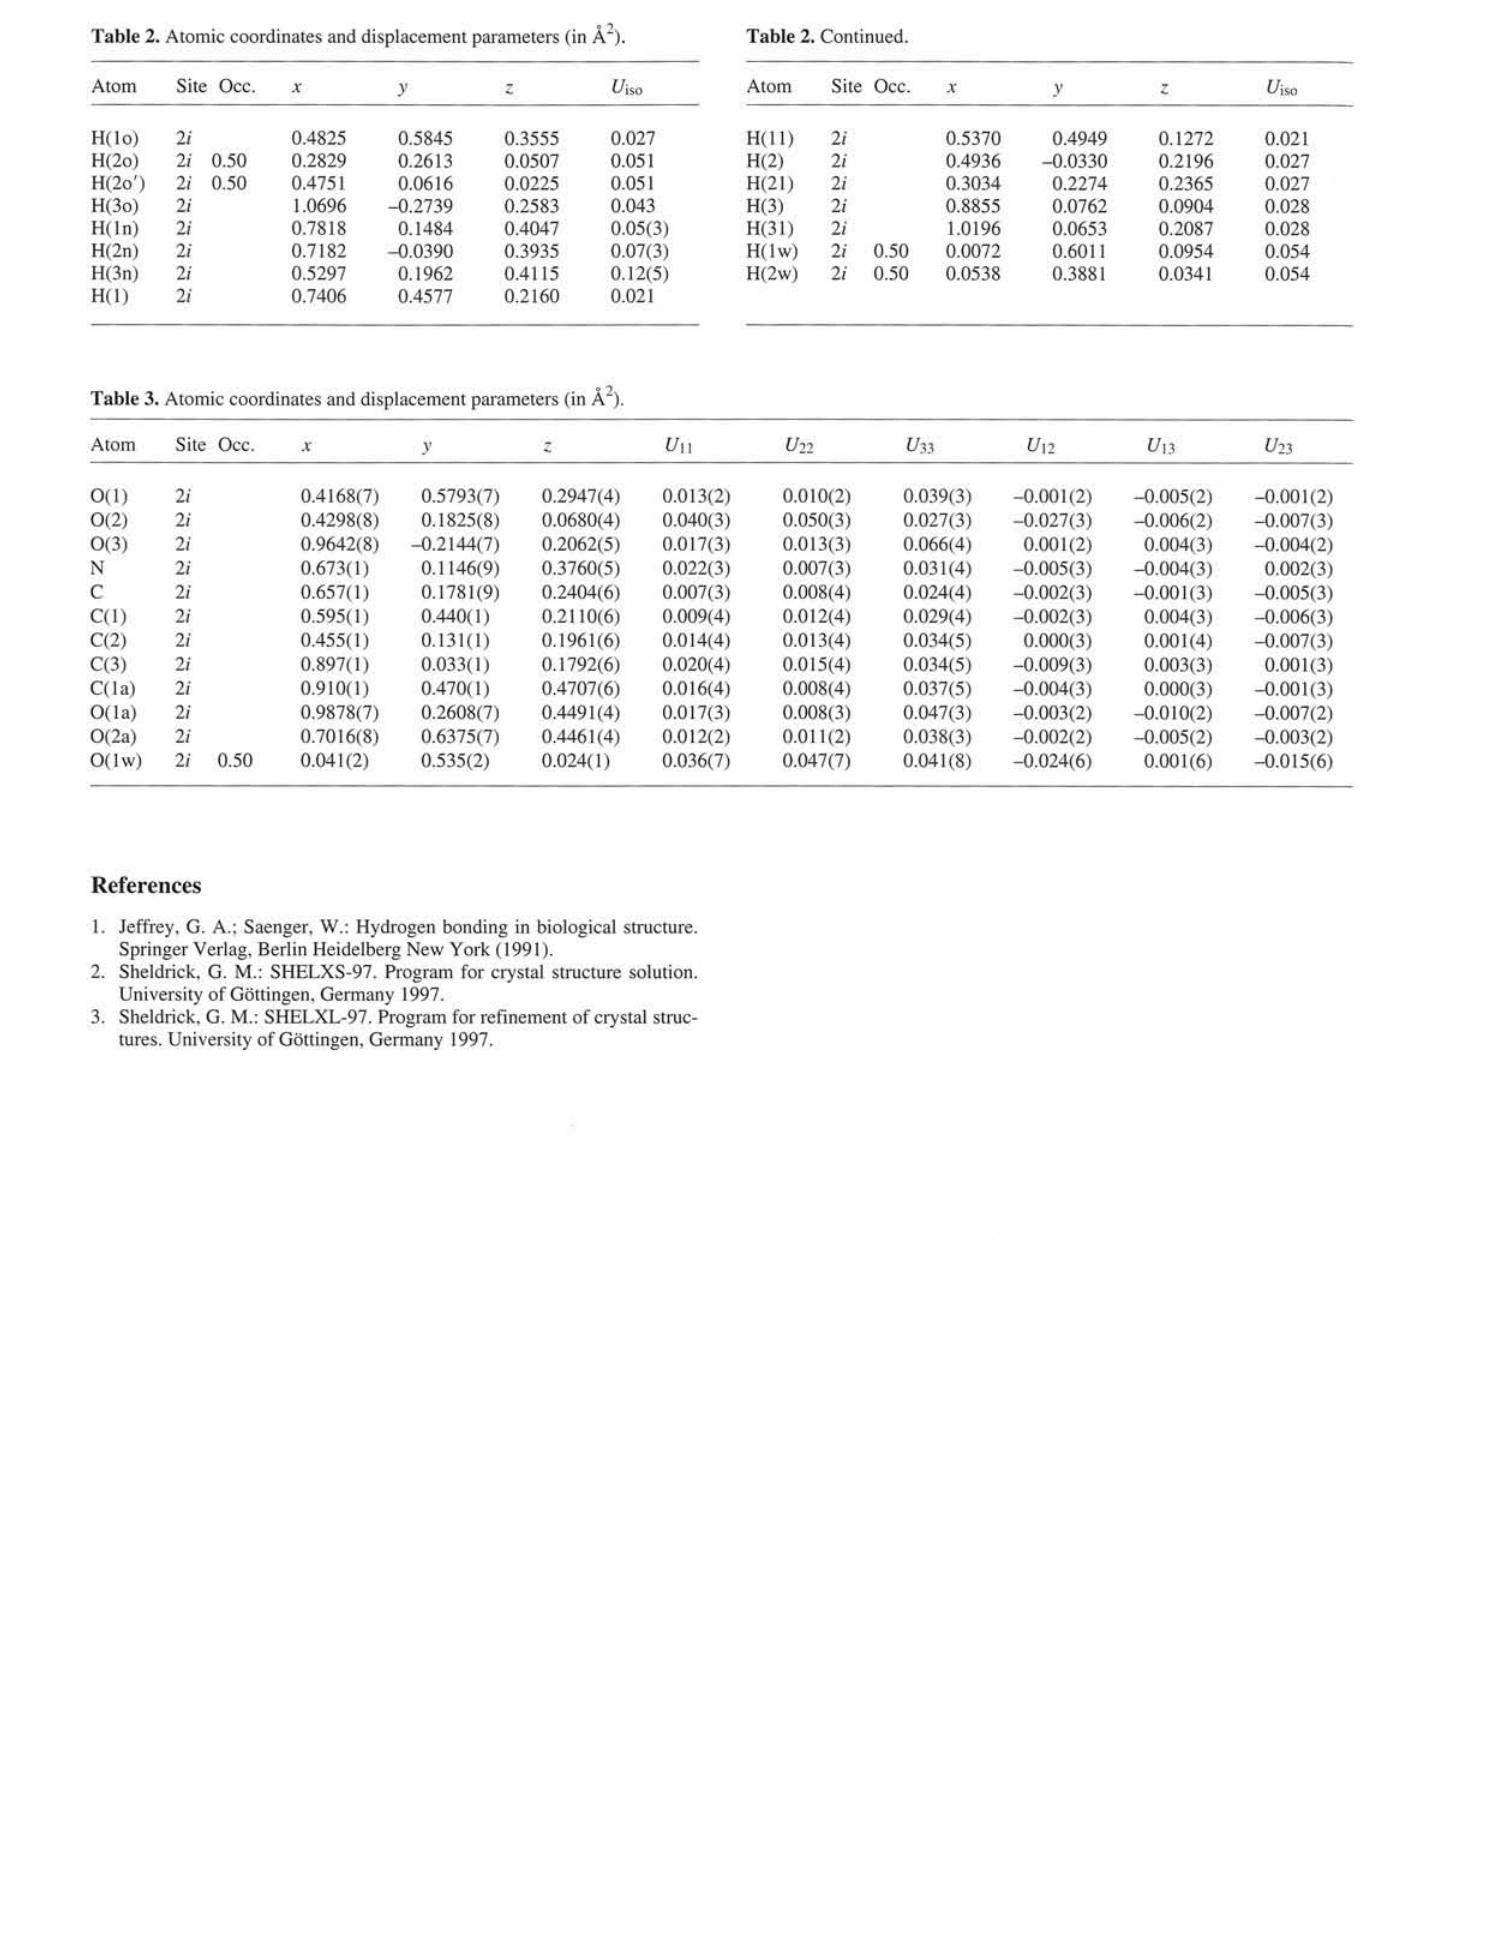
Table 3. Atomic coordinates and displacement parameters (in Á 2